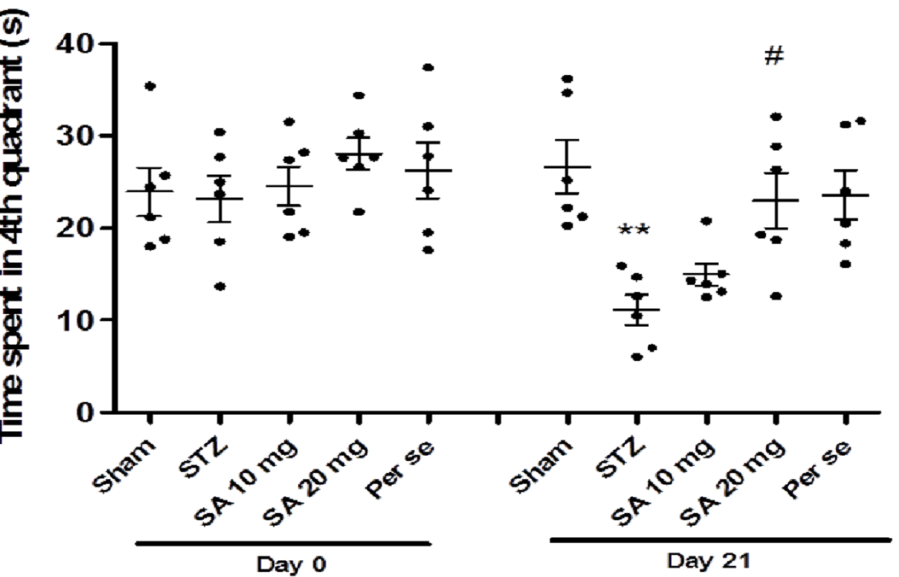
Figure 3. Time spent in the target quadrant in the Morris water maze test. Data are presented as mean ± SEM ( n = 6). * as compared to the sham group, # as compared to the STZ group. ** p < 0.01, # p < 0.05. STZ—Streptozotocin, SA—Sinapic acid.